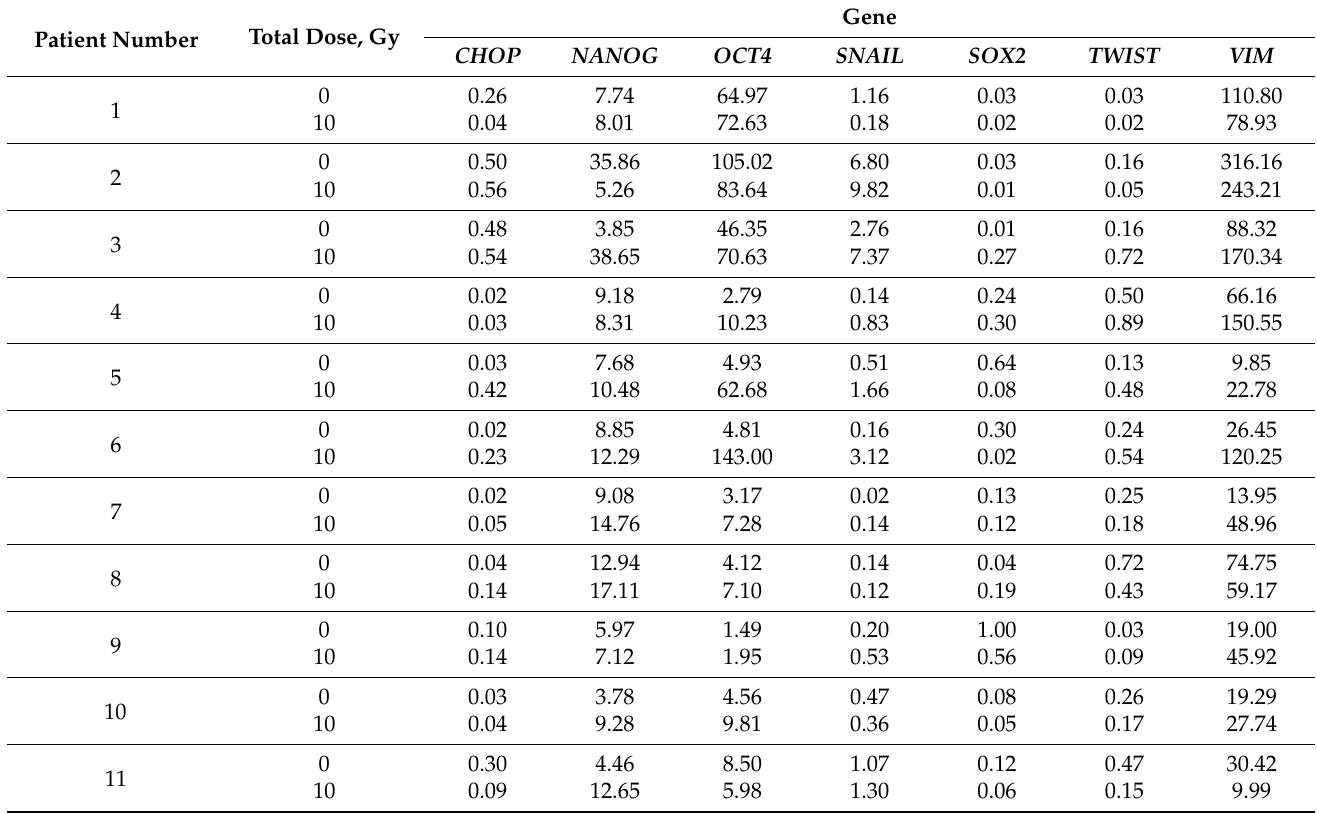
Table 2. Relative levels of mRNA expression of vimentin ( VIM ) and a number of stemness-related genes before treatment and after irradiation at a TD of 10 Gy against reference ( GAPDH and IPO8